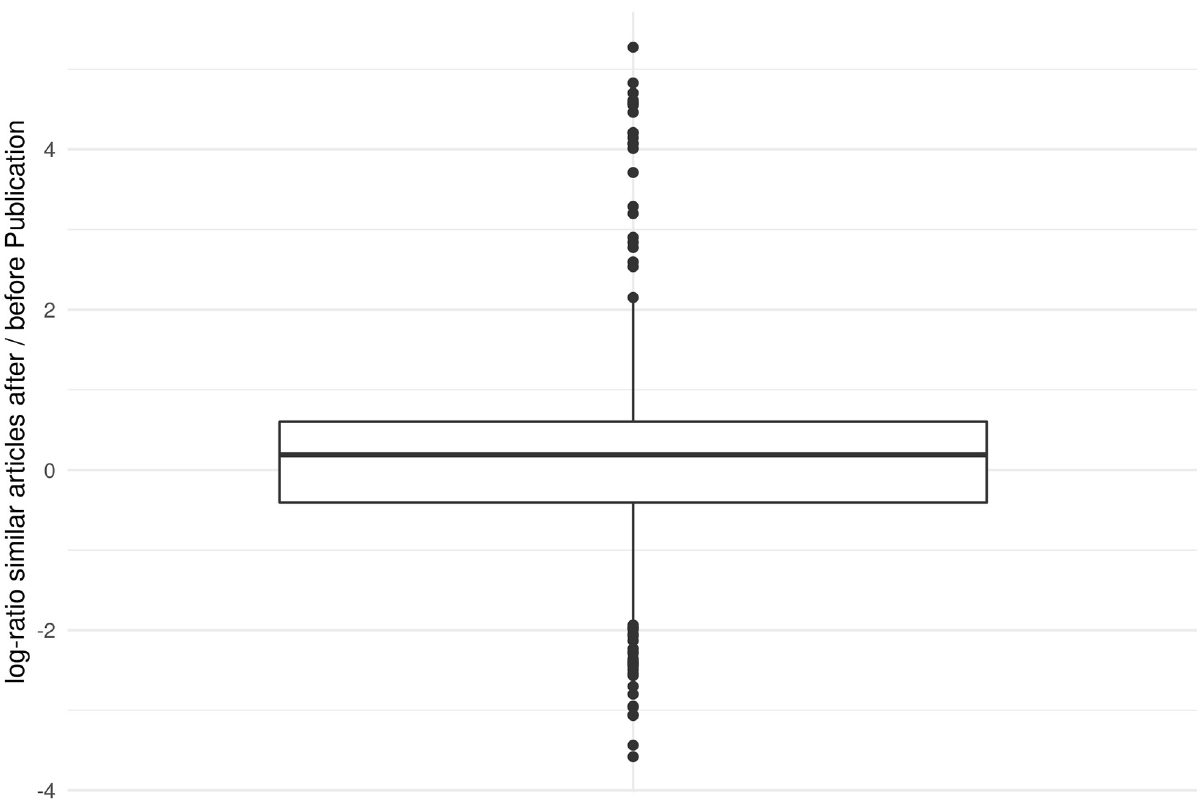
Fig 1. Increase respectively decrease of similar articles after publication of each MSM � 100 paper. Based on: 983 MSM � 100 papers. 15 Papers needed pseudo counts.